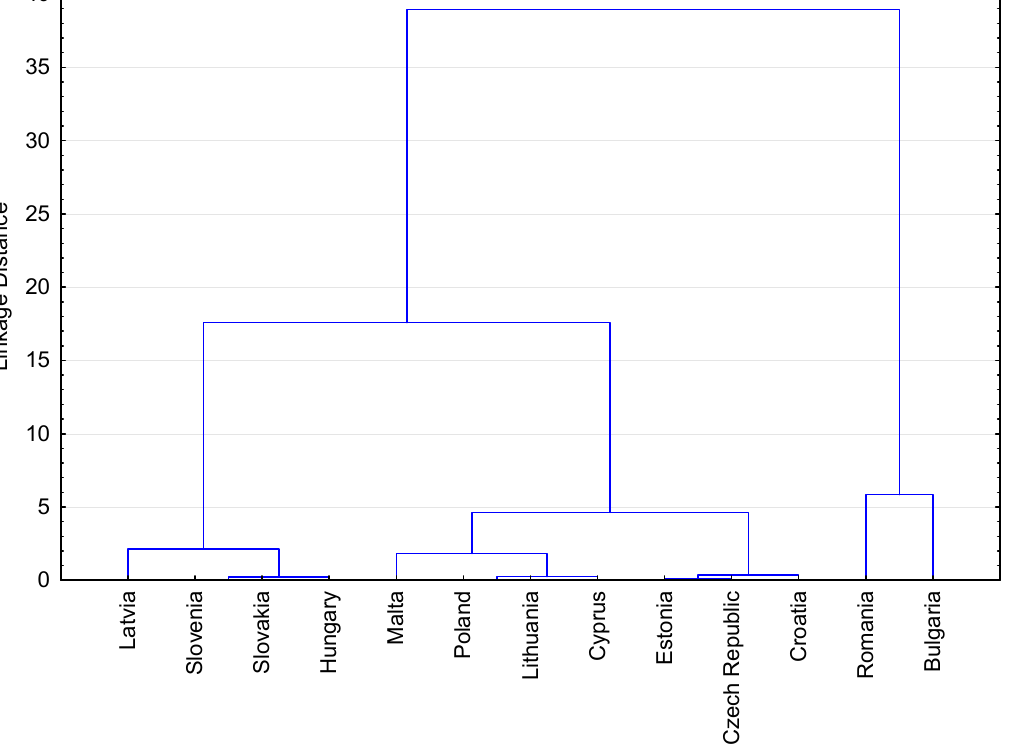
Table 11. Clusters for IREN in 2016.